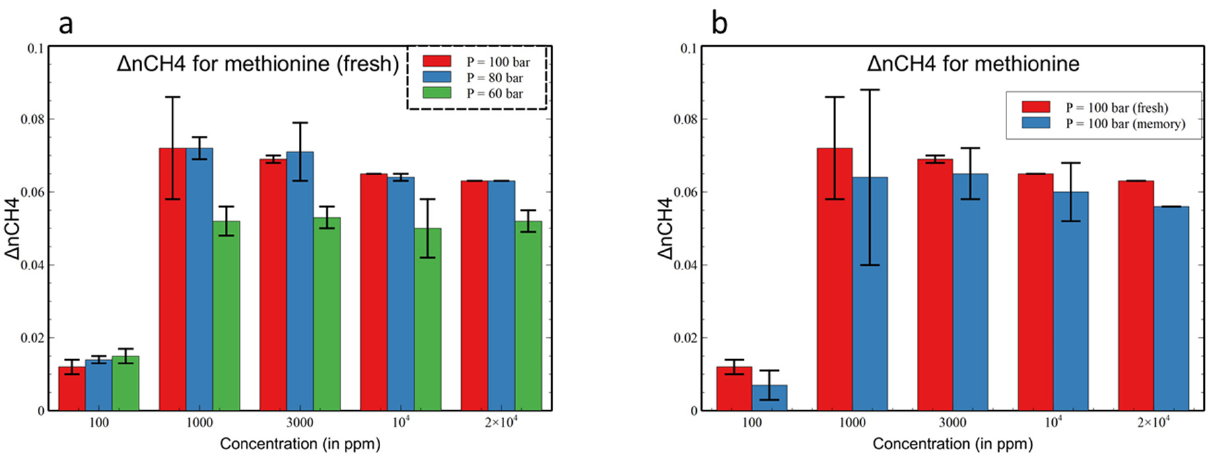
Figure 10. Total CH 4 uptake during an isothermal experiment at 1 °C for methionine at different concentrations. ( a ) Total gas uptake profiles for different concentrations under 60 bar, 80 bar and 100 bar. ( b ) Total gas uptake profiles for different concentrations under 100 bar for fresh and memory runs.